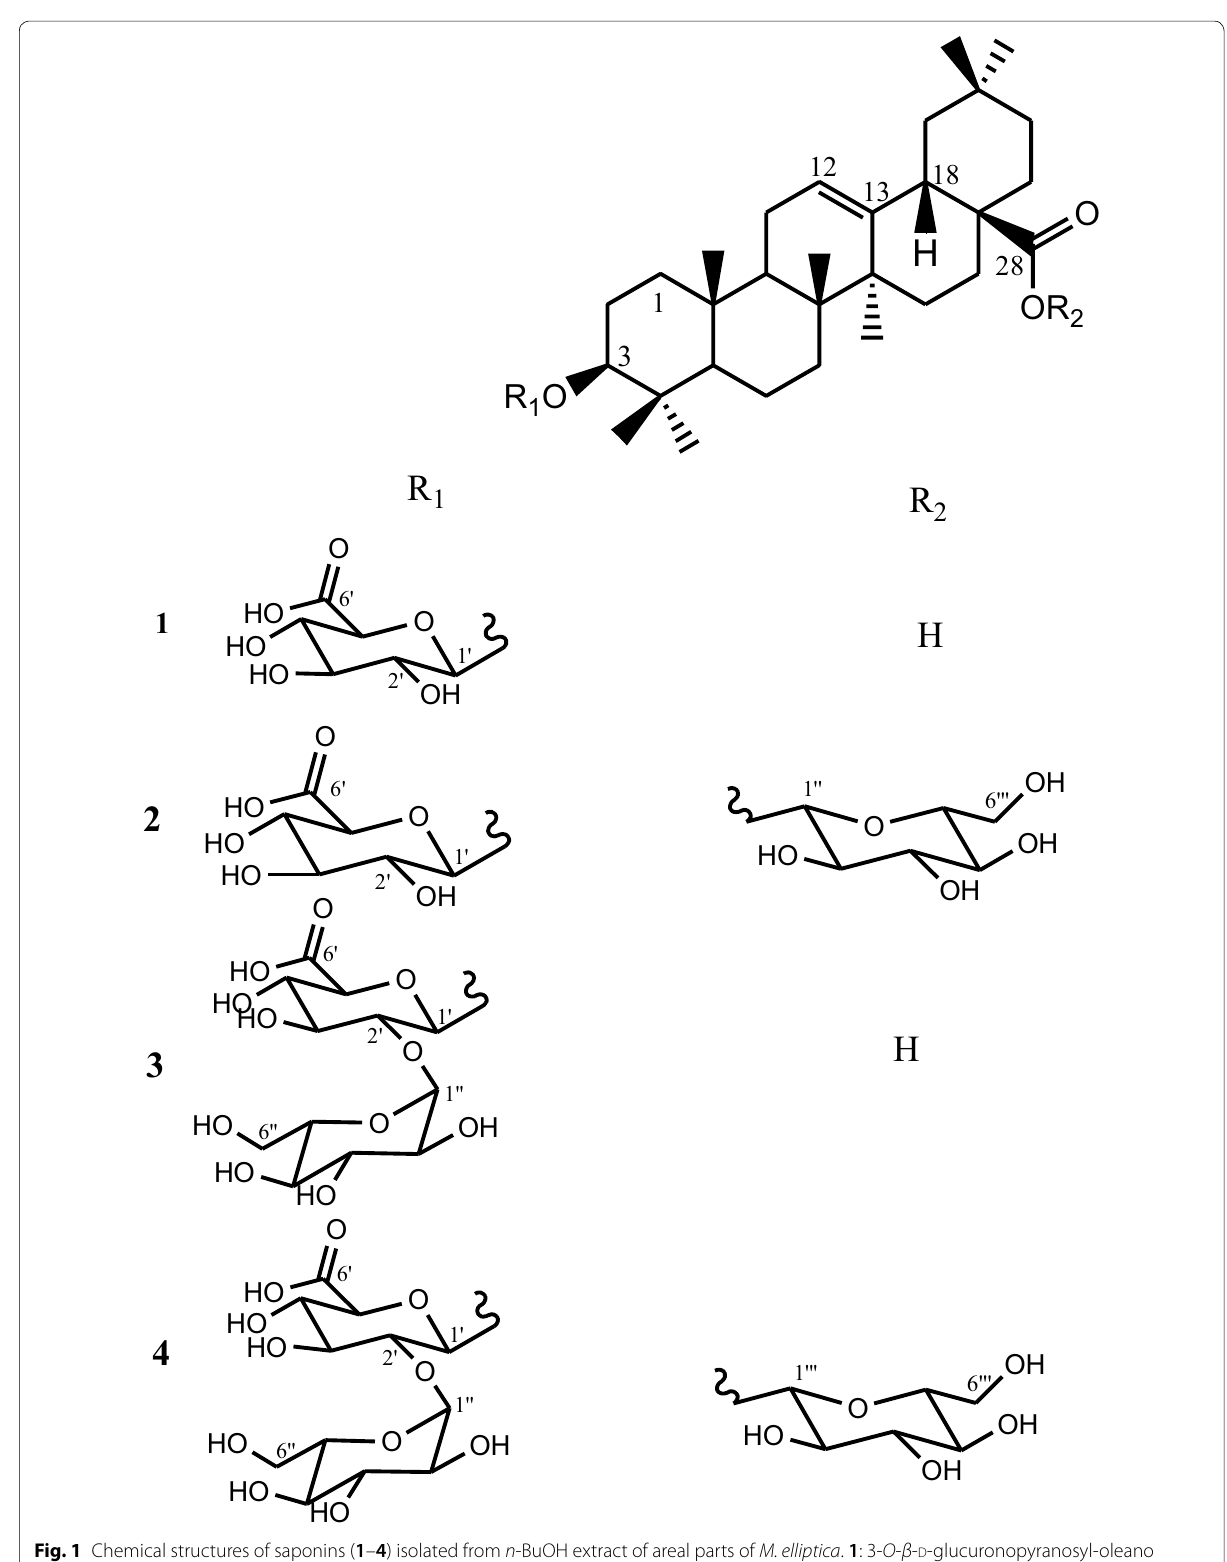
2)‑ β ‑ d ‑glucuronopyranosyl →